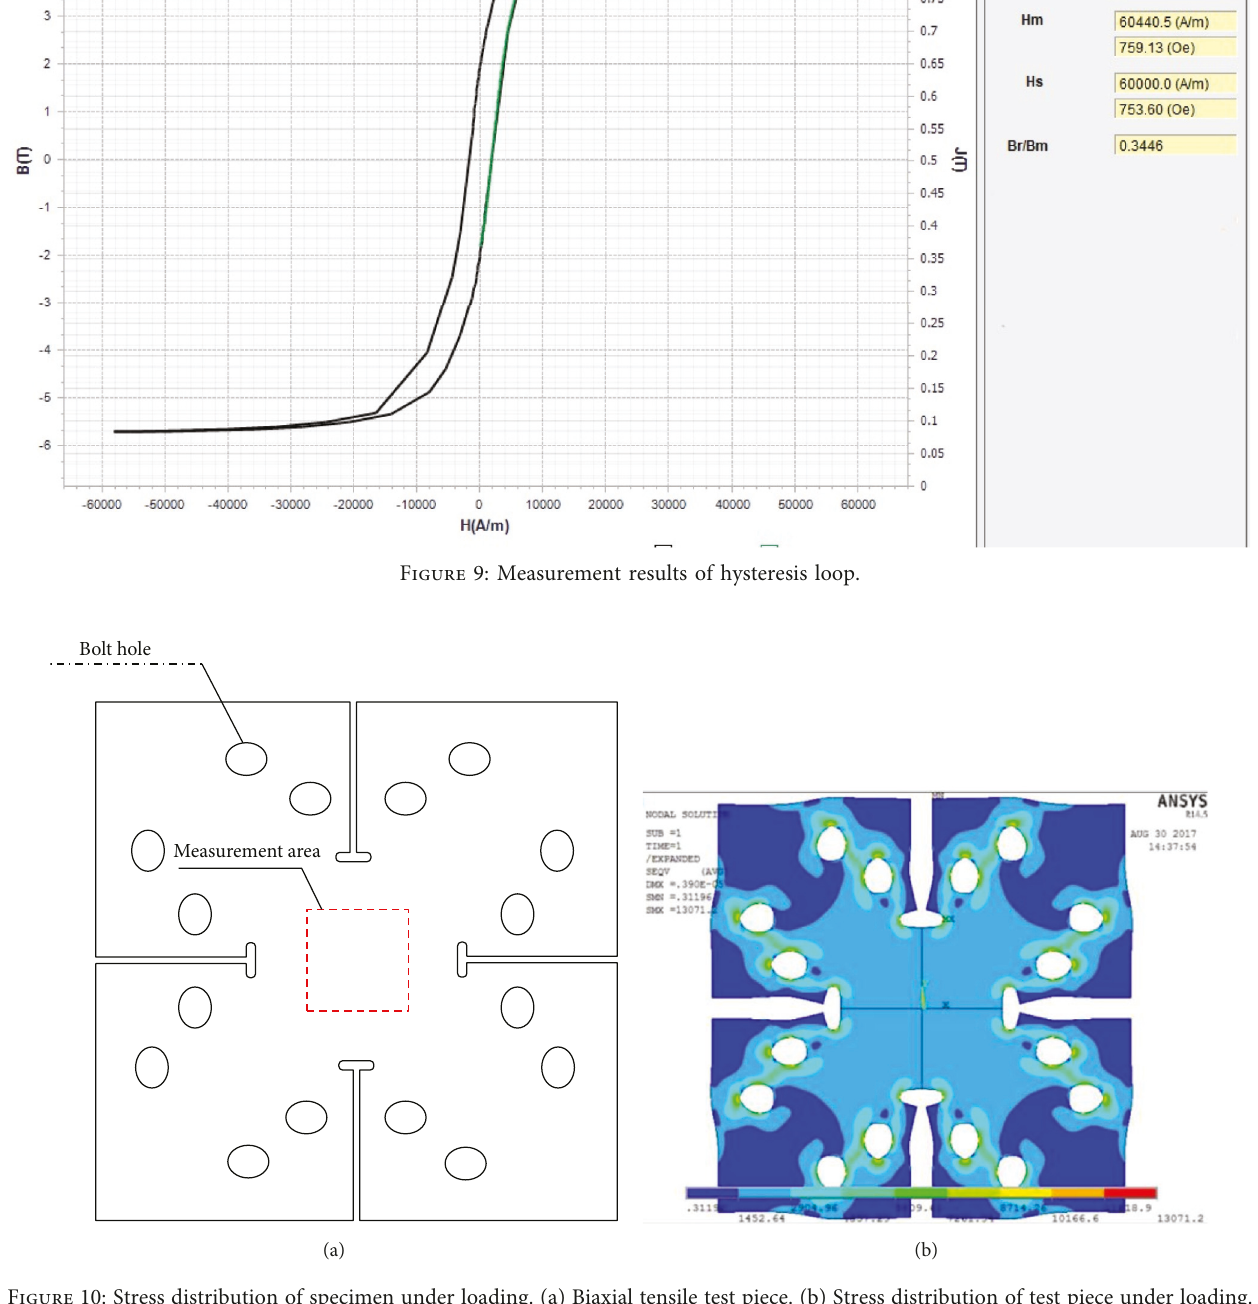
Figure 10: Stress distribution of specimen under loading. (a) Biaxial tensile test piece. (b) Stress distribution of test piece under loading.